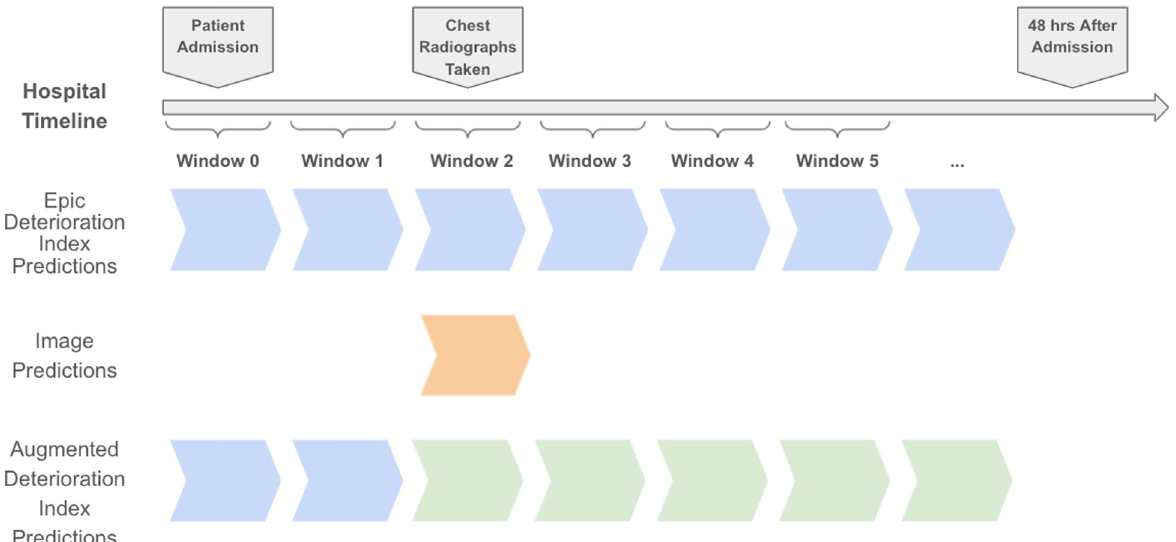
Fig 2. Prediction timeline during a hospitalization. A hospitalization timeline is shown for a hypothetical patient illustrating typical data availability and when predictions can occur. Image model predictions are made only during the time at which image studies are taken. The image- augmented deterioration index makes predictions for all windows after the image has been taken, using the deterioration index prediction prior to the first radiograph.